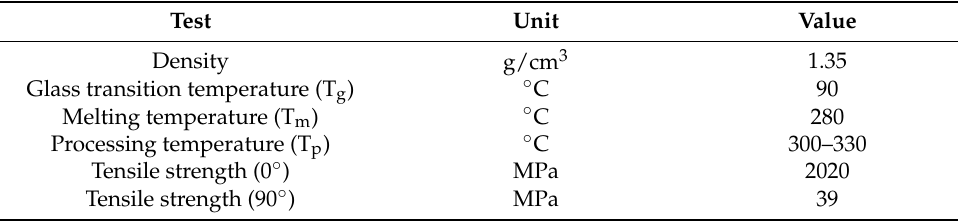
Table 1. Properties of the CF/PPS UD